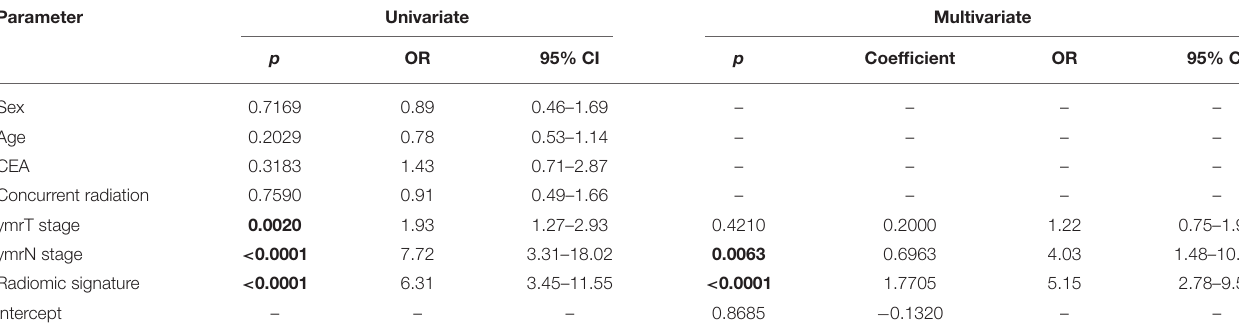
TABLE 3 | Univariate and multivariate logistic regression analysis for clinical characteristics and radiomic signature. Parameter Univariate